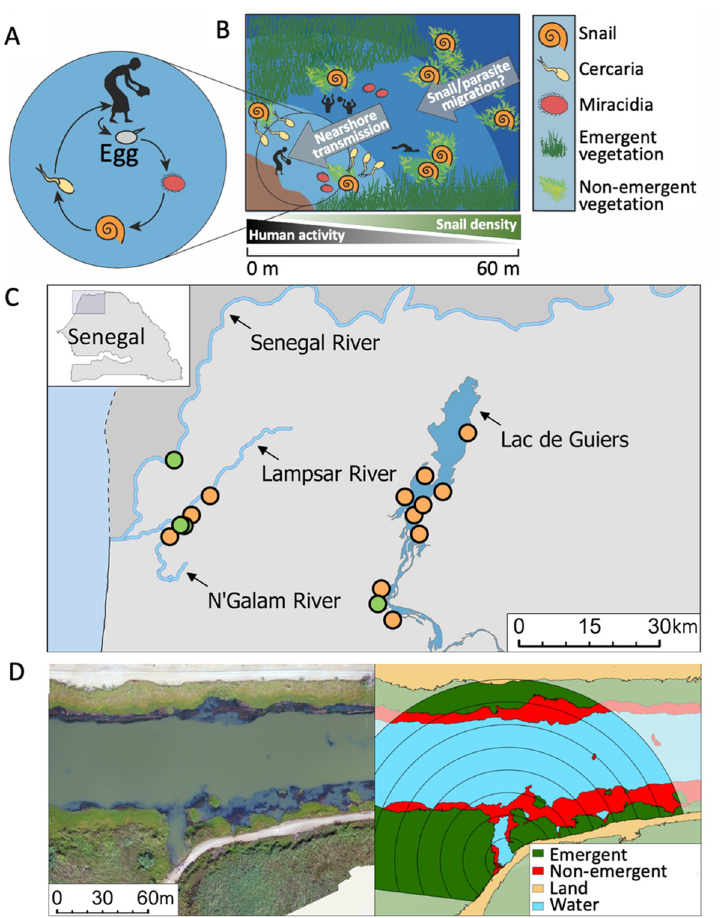
Fig 1. Schistosome life cycle, study design, and study location. A) Schistosome life cycle: eggs are deposited into water by infected humans; miracidia hatch from eggs and infect freshwater snails; larval schistosomes develop and free-swimming cercariae emerge and are infective to humans. B) Visual description of our hypothesized relationship between nearshore human schistosome risk and offshore intermediate host snail populations: we hypothesized that offshore snails represent a population source of susceptible intermediate host snails that, over relatively short periods of time (days), can disperse to nearshore areas and contribute to schistosome transmission cycles. C) Location of 16 study villages (encompassing 32 distinct water access sites) in the Senegal River Basin; 6 villages are located on river settings, and 10 villages are located adjacent to Lac de Guiers. Map was created using ArcGIS Pro v2.8.1 (www.esri. com). D) Overhead drone imagery (left) and classified non-emergent vegetation (red), emergent vegetation (green), water (blue), and land (tan) superimposed by sampling bands used to compare model fit across sampling radii, for a village on a river